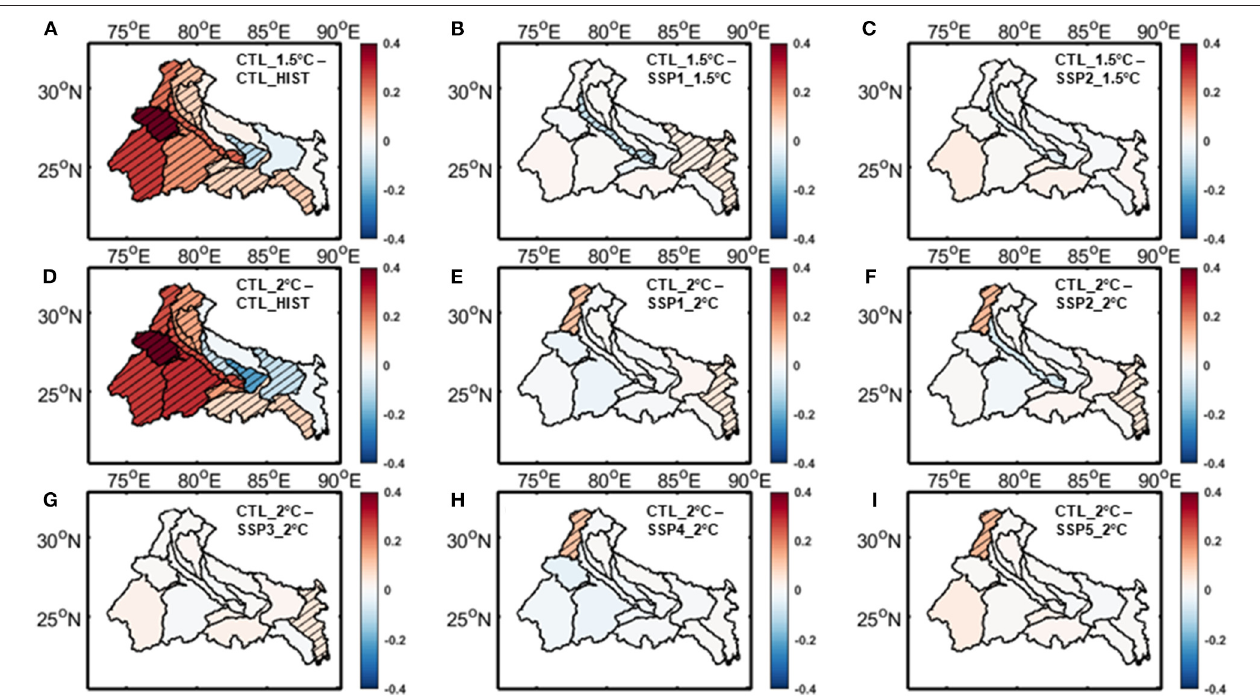
FIGURE 10 | Changes in VIC simulated aridity index associate with climate change for (A) 1.5 ◦ C warming, (D) 2 ◦ C warming and land use change for (B) SSP1_1.5 ◦ C scenario, (C) SSP2_1.5 ◦ C scenario, (E) SSP1_2 ◦ C scenario, (F) SSP2_2 ◦ C scenario, (G) SSP3_2 ◦ C scenario, (H) SSP4_2 ◦ C scenario, (I) SSP5_2 ◦ C scenario over Ganga river basin. Hatched regions denote areas with statistically significant